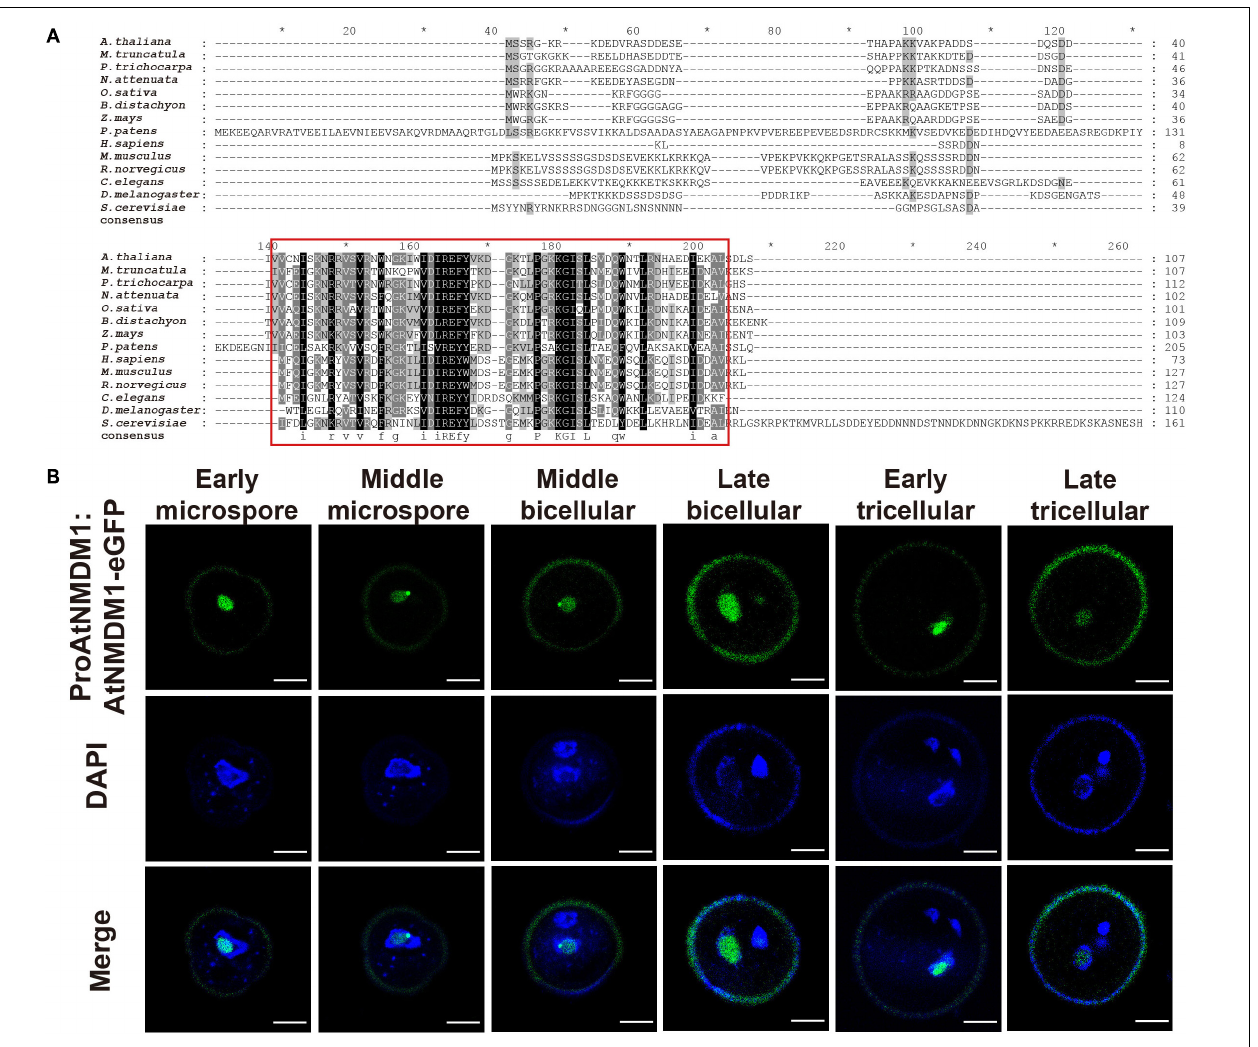
FIGURE 6 | AtNMDM1 encodes a conserved and nuclei-localized protein in pollen. (A) Multiple-sequence alignment of the AtNMDM1 proteins from different species was performed by ClustalX. Conserved regions of AtNMDM1 proteins are marked by red boxes. (B) Subcelluar localization of ProAtNMDM1:AtNMDM1-eGFP infusion protein during microgametogenesis. Representative pollen grains showed eGFP fluorescence (top, green), 4 (cid:48) ,6-diamidino-2-phenylindole (DAPI) fluorescence (middle, blue), and eGFP and DAPI fluorescence merged (bottom) at early microspore, middle microspore, middle bicellular, late bicellular, early tricellular, and late tricellular stages. Bar = 5 µ